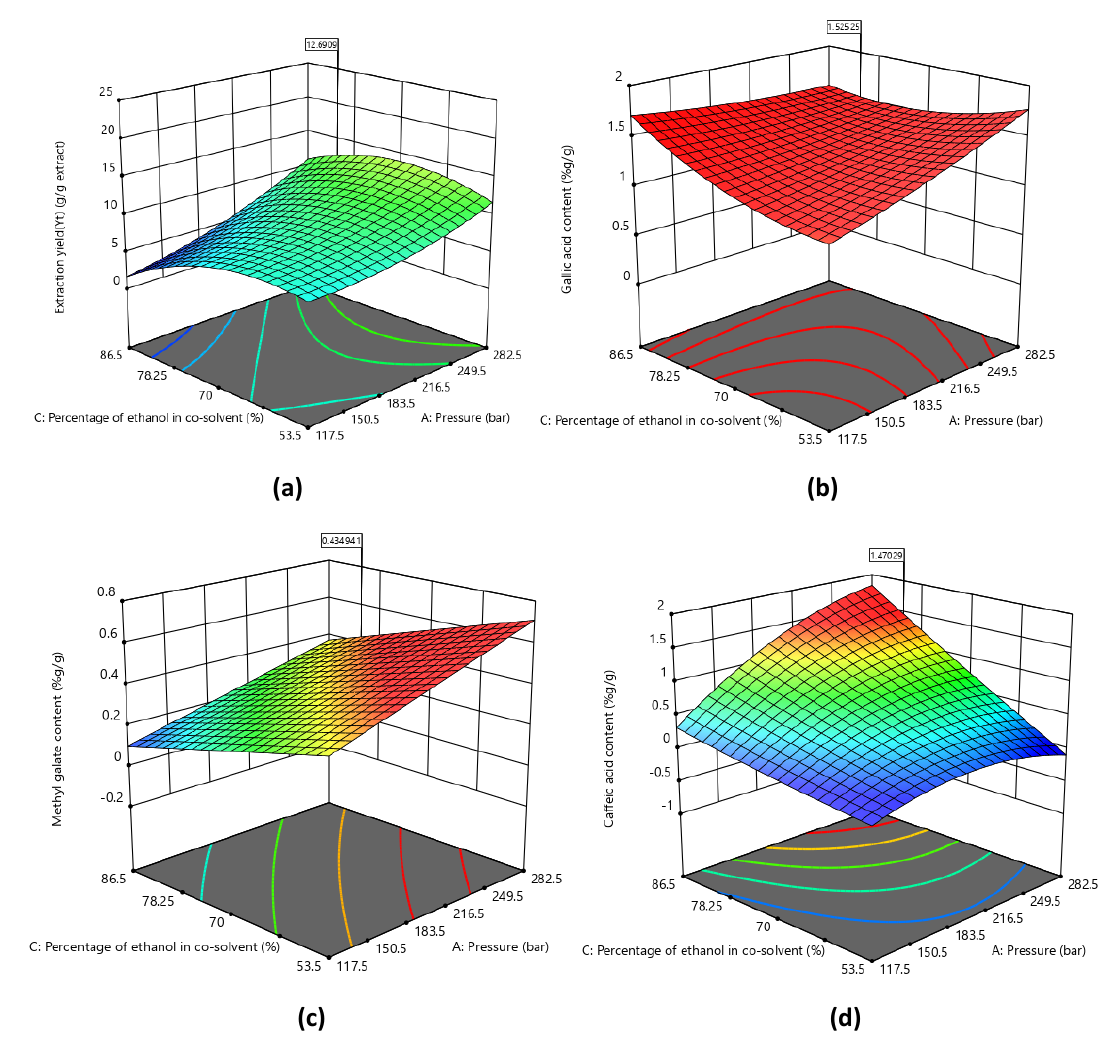
Figure 2 a-d Figure 2. Effect of pressure and percentage of ethanol in co-solvent on ( a ) extraction yield, ( b ) gallic acid content, ( c ) methyl gallate content, and ( d ) caffeic acid content.